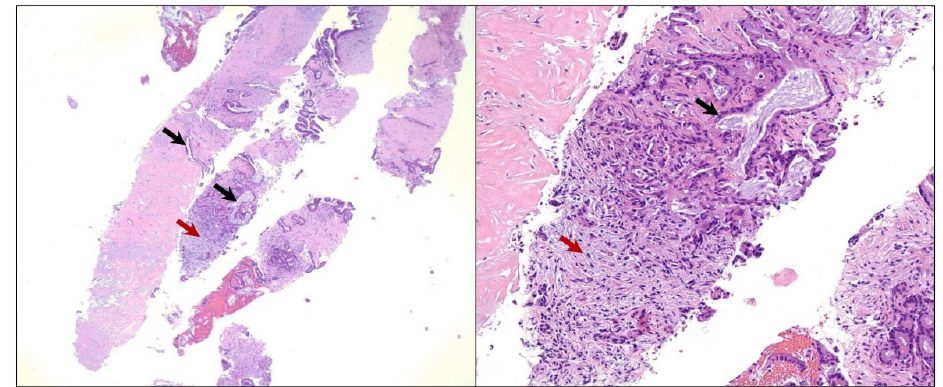
Figure 2. Microscopic image of the pancreatic fine needle aspiration specimen. Hematoxylin and eosin (H&E) staining showing neoplastic epithelial cells forming glands that are infiltrating the pancreatic stroma (black arrows). Also, a desmoplastic stromal reaction is seen (red arrows). The neoplastic cells show marked cytologic atypia, a high nuclear-cytoplasmic ratio, and nuclear pleomorphism, yielding a diagnosis of moderately differentiated adenocarcinoma in the head of the pancreas. Low-power magnification (40× objective) is shown in the panel to the left and high-power magnification (200× objective) is shown in the panel to the right.